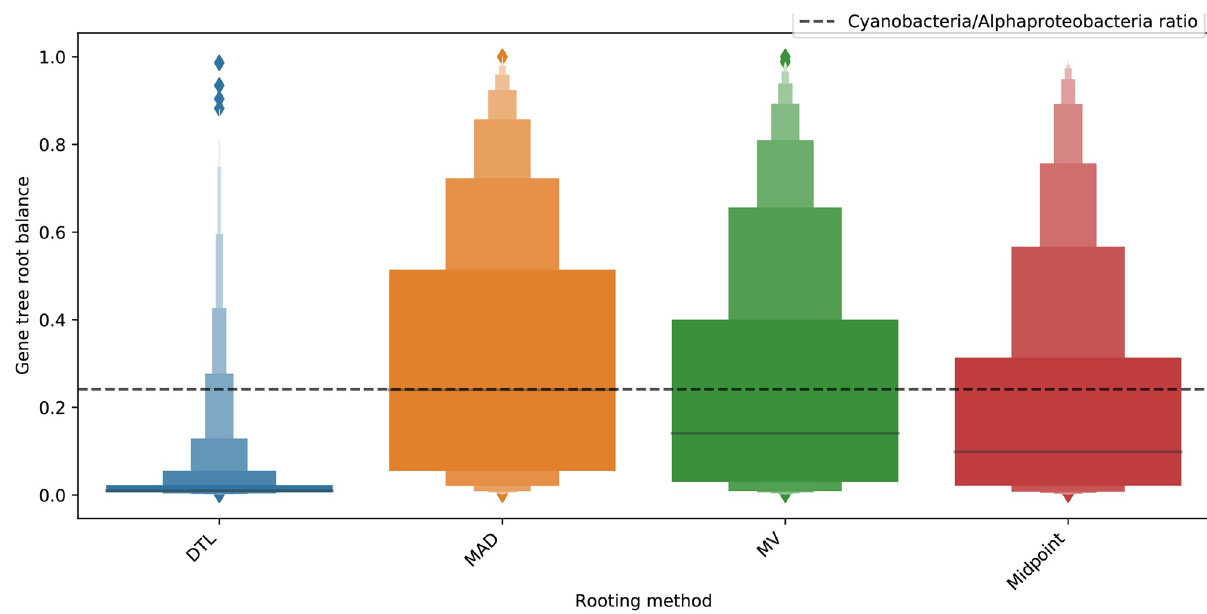
Fig 7. Letter-value plot of root balance distributions as inferred by DTL, MAD, MV, and midpoint rooting on all 3098 gene trees in our empirical data set. The dashed horizontal line represents the Cyanobacteria and Alphaproteobacteria ratio (0.2413). As the plot shows, MAD rooting yields root balances closest to the expected root balance. Results for all five rooting methods on the 3093 gene trees on which ALE rooting could be executed are shown in Fig A6 in S1 Appendix.